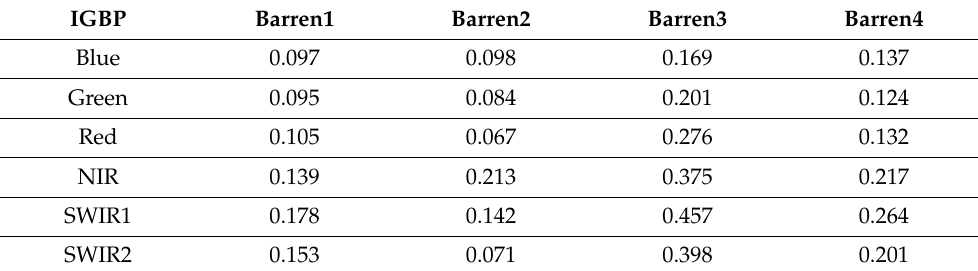
Figure 2. Global NIR reflectance distribution of barren land cover. Note that the colored stars are the reflectance values for each group calculated by the k-means algorithm. Table 4. Separated barren reflectance profiles. Table 4. Separated barren reflectance